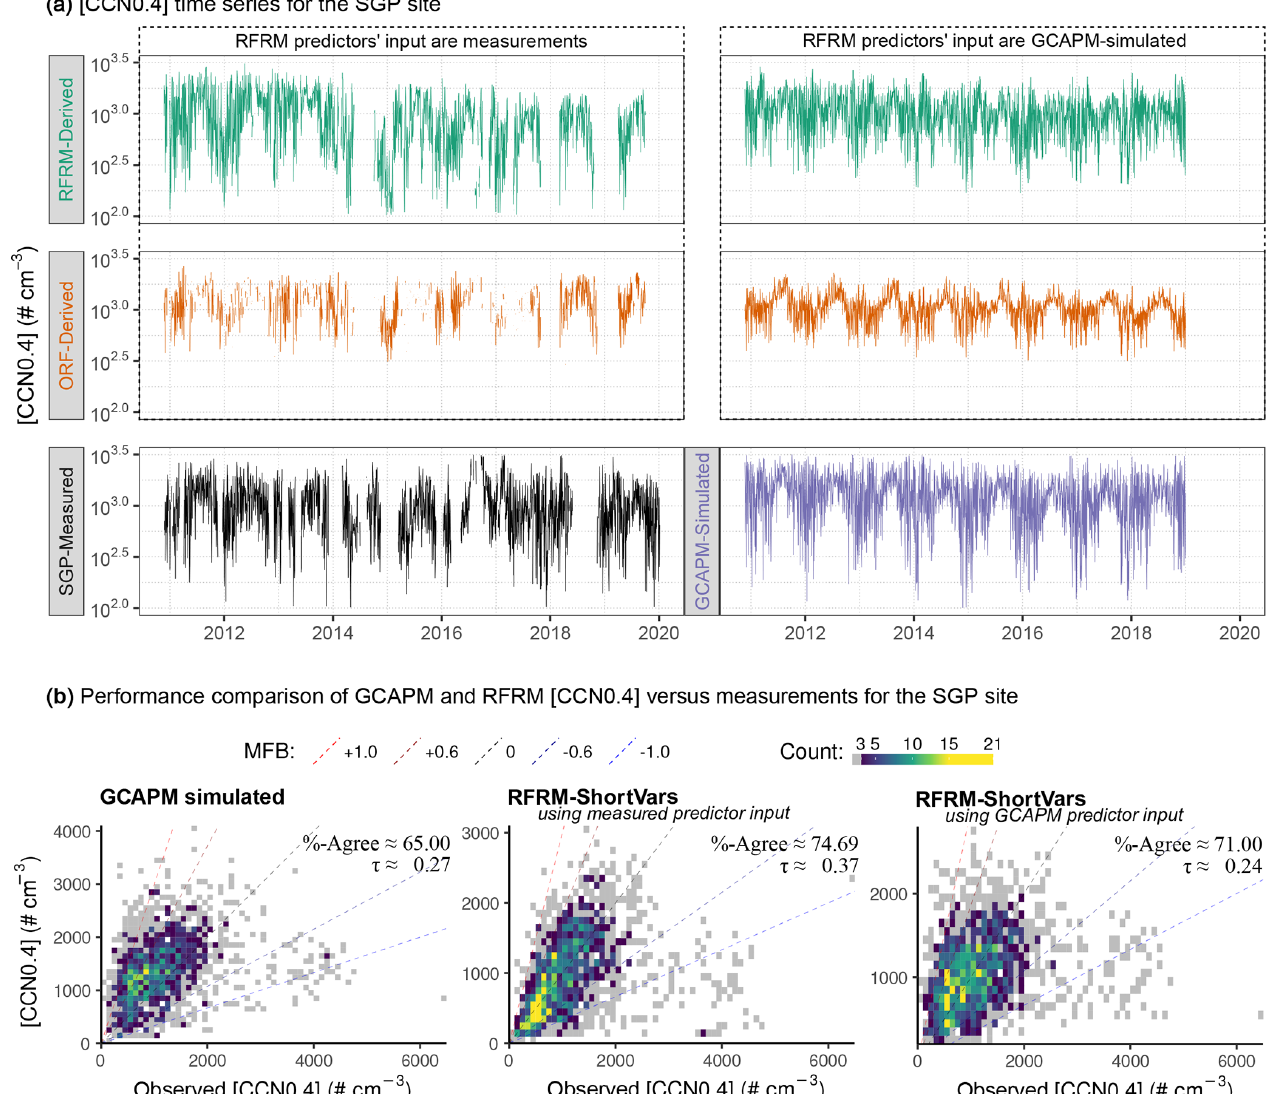
Figure 12. (a) Time series (daily-aggregated) for [CCN0.4] derived by RFRM-ShortVars (top two) and ORF (middle two), compared to SGP measured (bottom-left) and GCAPM-simulated (bottom-right). (b) Performance comparison of the models in quantifying [CCN0.4] compared to its measured values for the SGP site: left – GCAPM; center – RFRM-ShortVars with measurements of predictors as input; right – RFRM-ShortVars with GCAPM-simulated predictors as input. The summary performance metrics are τ : Kendall’s rank correlation coefficient and %-Agree: the percentage of pairwise model–observation compared values within the good-agreement range defined as − 0 . 6 < MFB < + 0 .